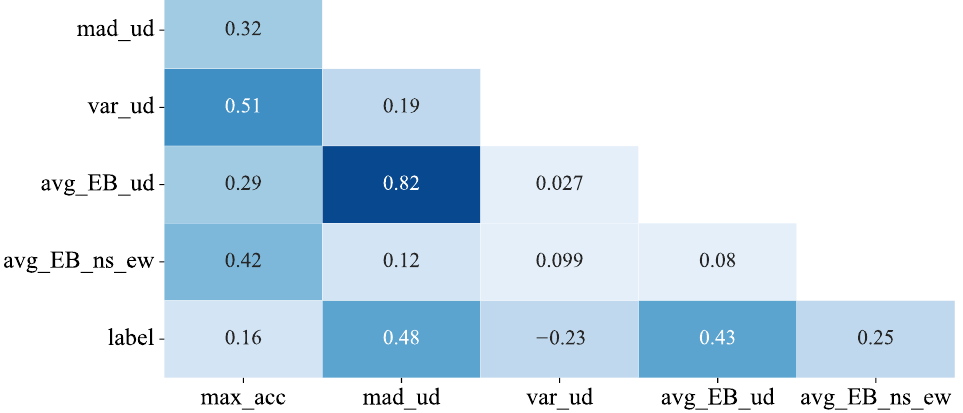
Figure 5. Heatmap of the feature correlation coefficients. max_acc: the peak acceleration in a frame; mad_ud: the MAD of the UD component; var_ud: the variance of the UD component; avg_EB_ud: the average time-domain energy of the UD component; avg_EB_ns_ew: the average time-domain energy of two horizontal components; label: the data label. If it is 1, the data is an earthquake event, and non-seismic data if it is 0.